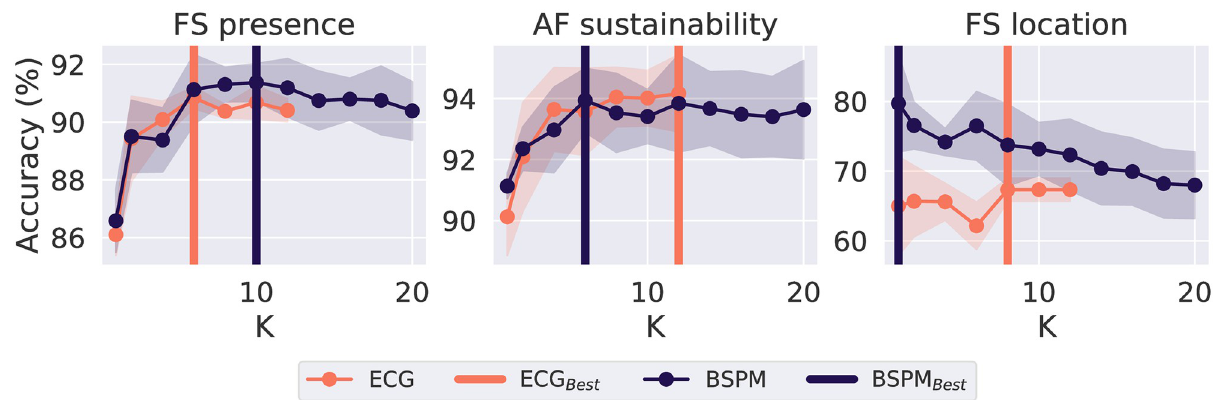
Fig 5. Means (points) and standard deviations (shaded areas) of the test accuracy scores using leave-one-patient-out cross validation, for changing K and lead systems (ECGs or BSPMs), on the classification tasks, with the best K for the highest accuracy (ECG setting shown by vertical